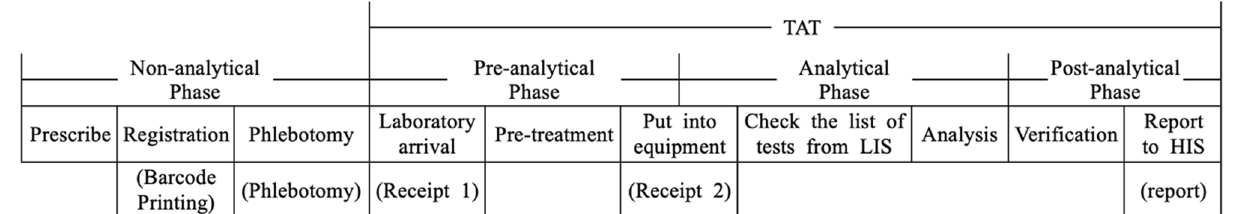
Figure 1. Laboratory workflow in a ward at the St. Vincent’s